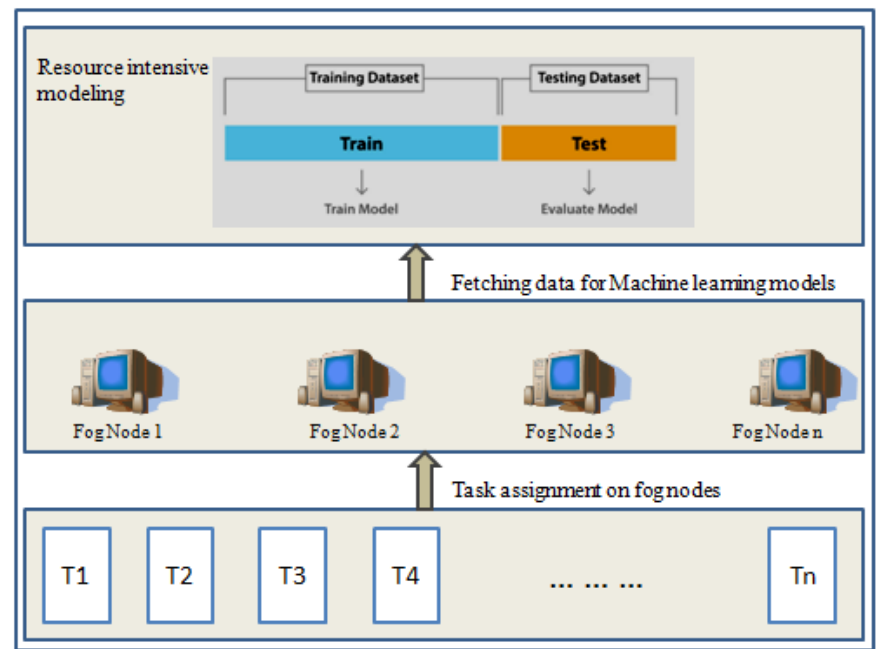
Figure 2. Proposed fog architecture for task allocation.